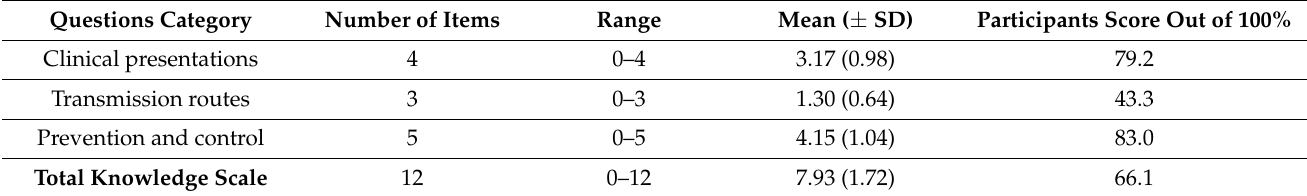
Table 2. Participants’ mean scores for COVID-19 knowledge per